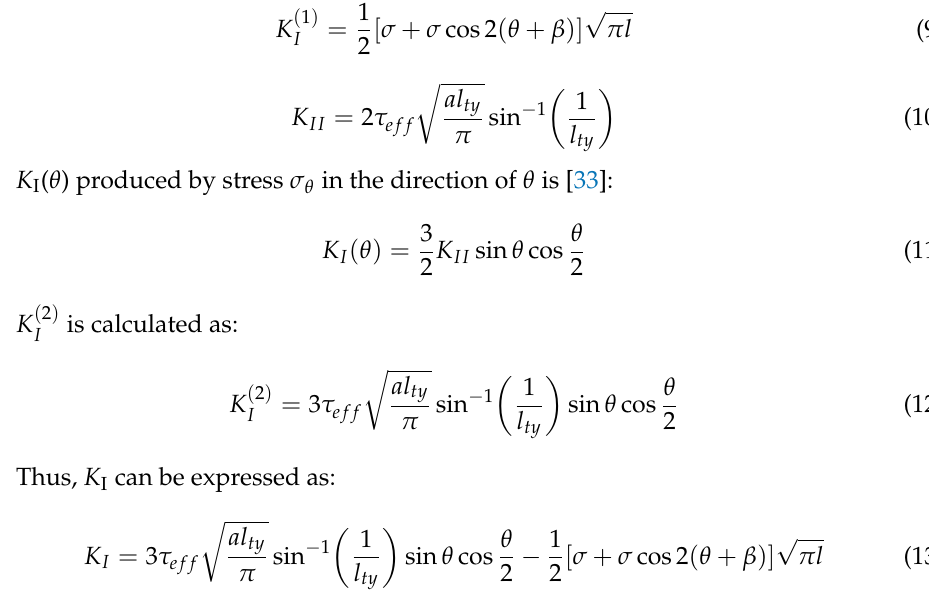
is calculated as: Thus, K I can be expressed